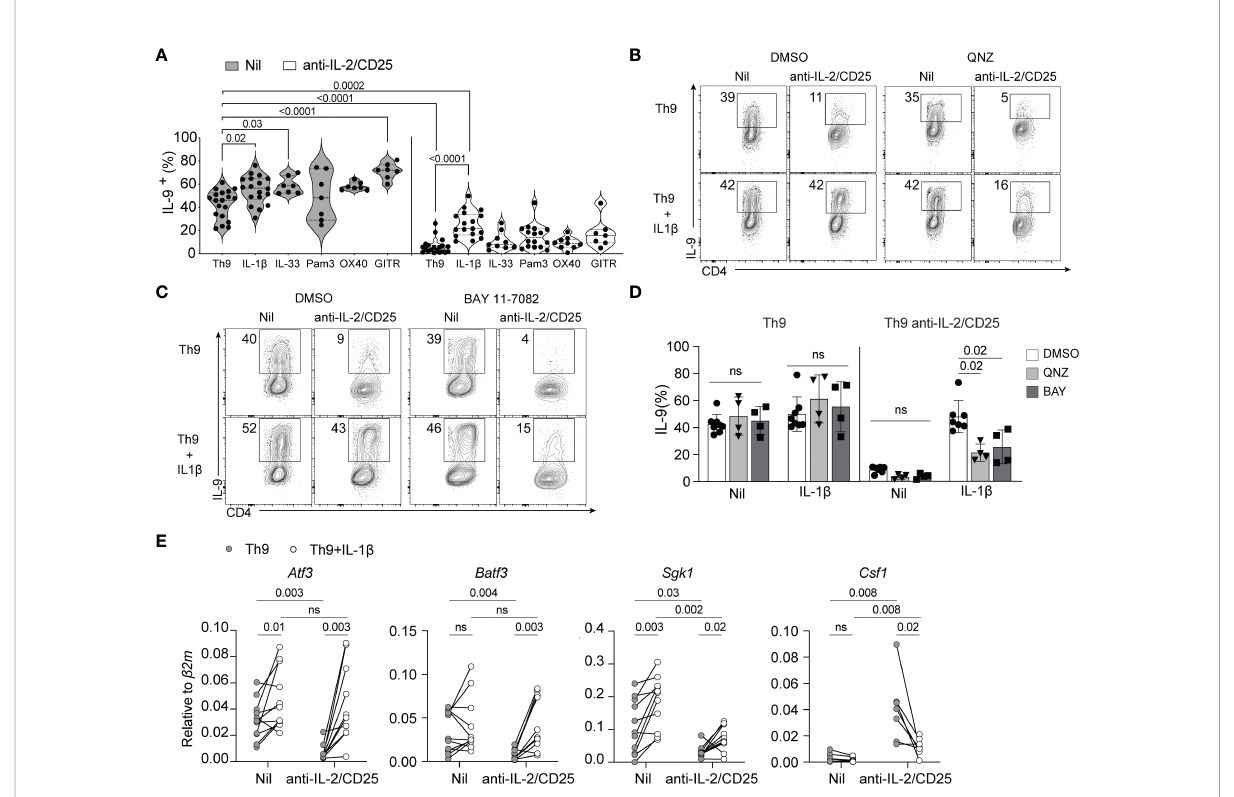
FIGURE 2 IL-1 b -induced NF-kB rescues Th9 differentiation in IL-2-limiting conditions. (A) Th9 cells were cultured in standard or IL-2-limiting conditions in the presence of the indicated NF-kB-activating cell surface receptors and cytokines, and intracellular IL-9 was measured at day 5 of culture after restimulation of cells with PMA and ionomycin. Each data point represents cells from at least n=7 mice or more per group. (B, C) Representative contour plots of IL-9 production of Th9 and IL-2-deprived Th9 cells in the presence or absence of IL-1 b and the NF-kB inhibitors QNZ (1nm) or BAY 11-7082 (2.5 m M), depicting the NF-kB-dependency of IL-1 b -mediated rescue of Th9 cell differentiation. (D) Quanti fi cation of IL-9 + Th cells in culture with NF-kB inhibitors, each data point represents naïve T cell cultures from individual mice n= 4 mice from drug-treated cells and n=7 for DMSO controls. (E) NF-kB-associated gene expression at day 5 of culture from non-restimulated Th9 and IL-2-deprived Th9 cells cultured in the presence or absence of IL-1 b . Each point represents data from T cells isolated from at least 8 or more mice per group. Data are considered signi fi cant if p value ≤ 0.05 in a one-way ANOVA analysis with a Tukey post-test. Error bars represent standard deviation. ns, non-signi fi